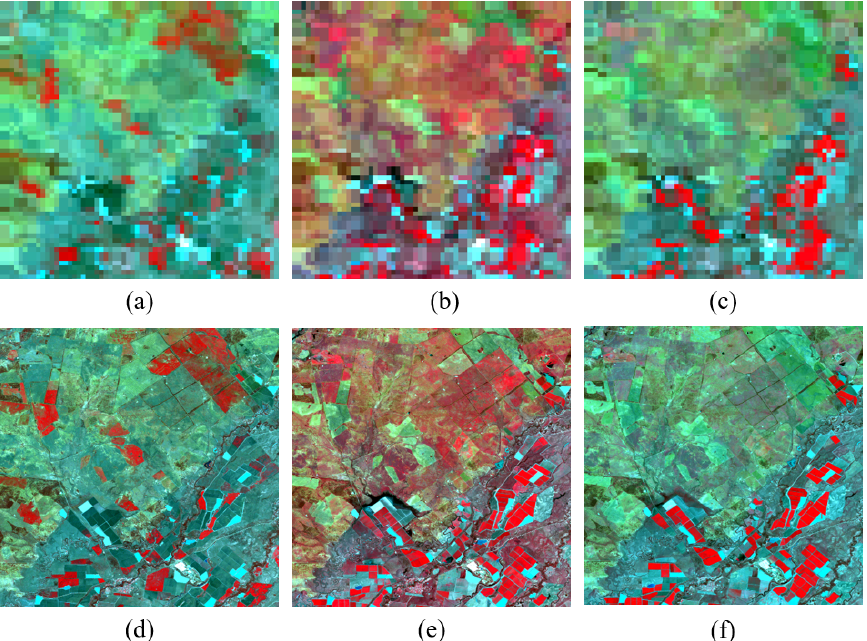
Figure 7. Comparison of LGC image pairs on 22 August 2004, 28 December 2004 and 13 January 2005. ( a , d ) are the MODIS and Landsat images on 22 August 2004, respectively. ( b , e ) are the MODIS and Landsat images on 28 December 2004, respectively. ( c , f ) are the MODIS and Landsat images on 13 January 2005,